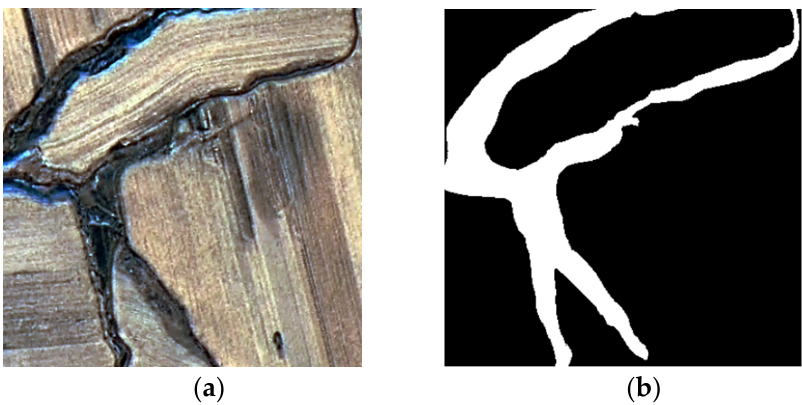
Figure 6. The sample from the HC2020 dataset and its corresponding label. ( a ) Sample. ( b ) Corresponding label. In ( b ), white and black pixels stand for gully erosion and non-gully erosion, respectively.